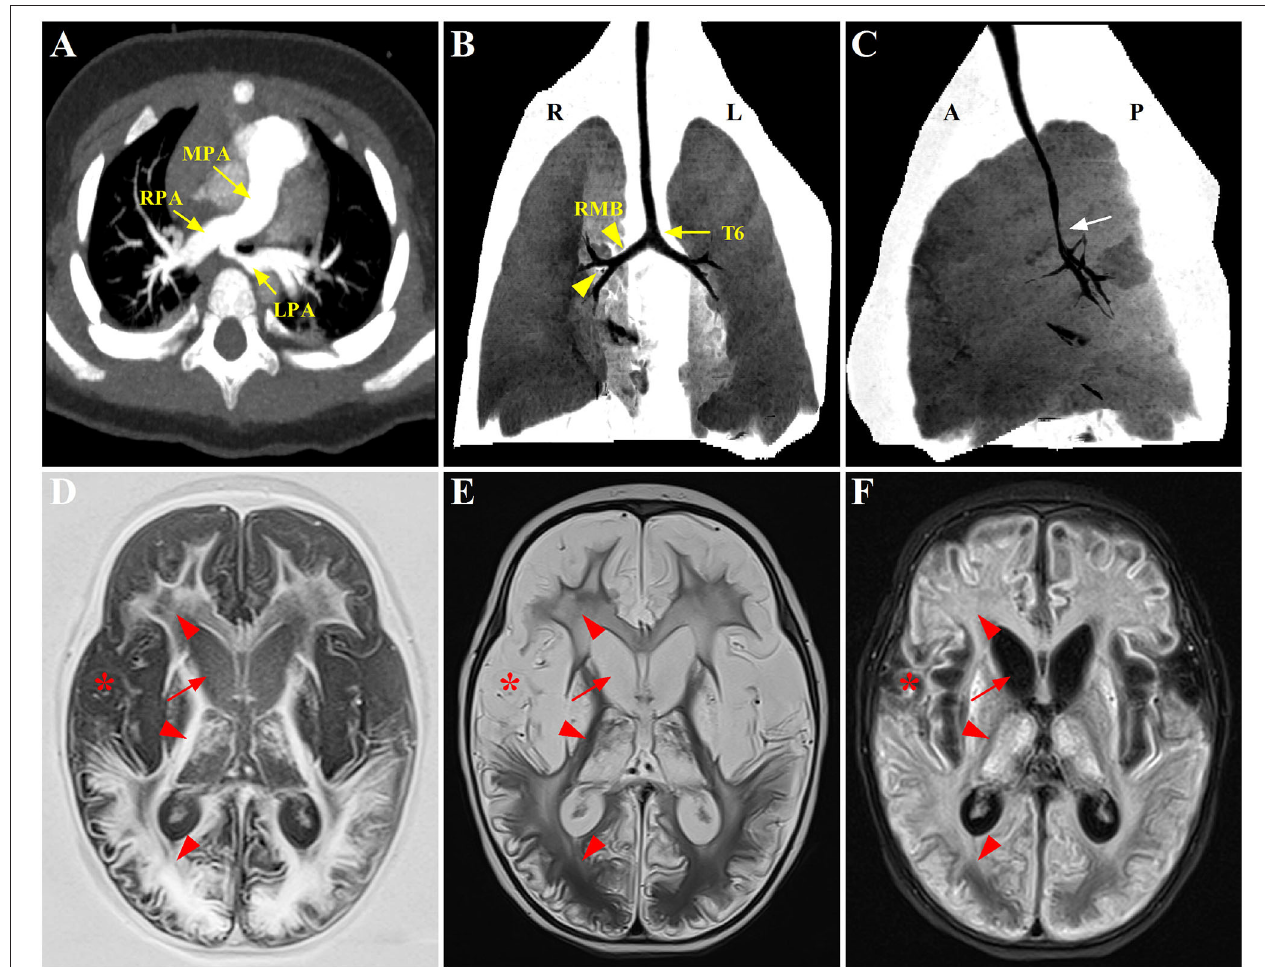
FIGURE 1 | Radiographic evaluation of the PAS, tracheobronchial abnormalities, and neurological lesions through CT and MRI scans. (A) Preoperative CTA showing the anomalous origin of LPA from the posterior aspect of RPA. (B,C) Postoperative three-dimensional reconstruction of CT showing a lower level of bronchial bifurcation at T6 (yellow arrow) and a long RMB with bronchial divisions identical to left bronchial type (yellow arrowhead), associated with a stenotic segment in the distal trachea (white arrow); (D–F) Axial T1-weighted, T2-weighted, and T2-FLAIR brain MRI, respectively, displaying symmetrical signal abnormalities throughout the gray matter, white matter, and deep nuclei (red arrowhead), and extensive cortical necrosis (red asterisk), cerebrum atrophy and ventriculomegaly (red arrow). PAS, pulmonary artery sling; CTA, computed tomography angiography; LPA, left pulmonary artery; RPA, right pulmonary artery; RMB, right main bronchus; FLAIR, fluid attenuated inversion